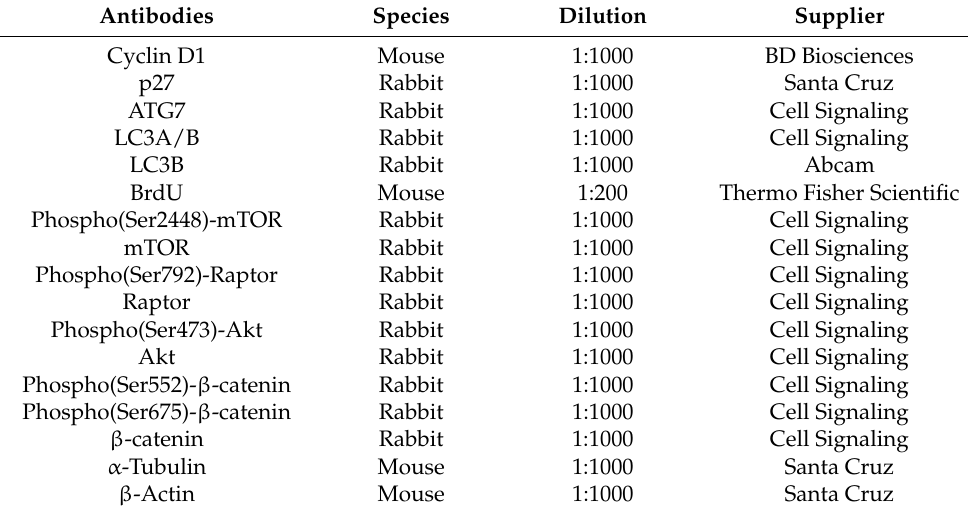
Table 1. List of antibodies used for